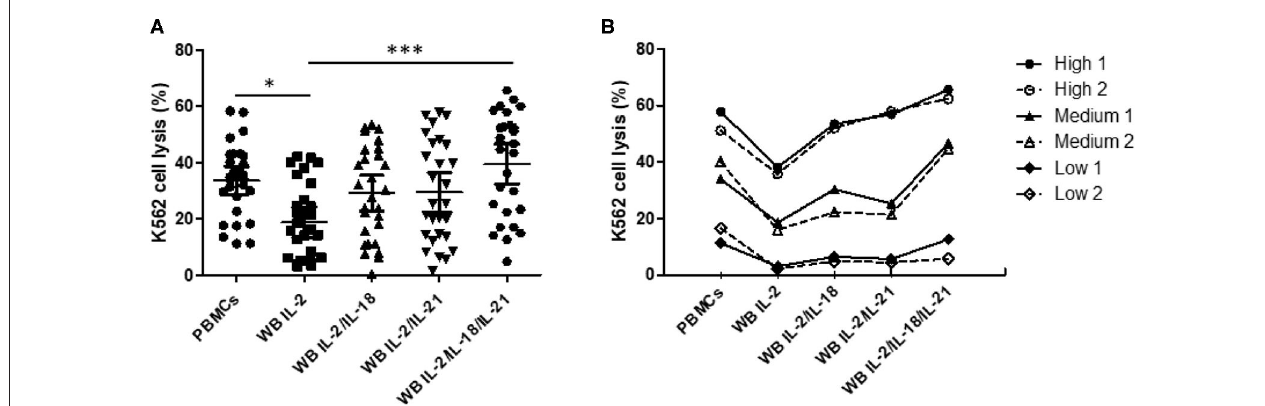
FIGURE 3 | Comparison of NK cytotoxicity between the 4-h peripheral blood mononuclear cell (PBMC) assay without cytokine stimulation and the overnight whole blood (WB) assay with multiple cytokine combinations. PBMCs or WB were co-incubated with K562 cells, with various cytokine combinations added to WB, for 4h (PBMCs) or overnight (WB). PBMC assays were performed at an E:T ratio of 40:1; WB assays used 200 µ L WB. (A) Scatter plots of NK cytotoxicity in PBMCs and WB samples from 28 donors. Data are represented as the mean ± SEM (* p < 0.05; *** p < 0.001). (B) Representative data from two donors each with low, medium, and high NK cell cytotoxicity.